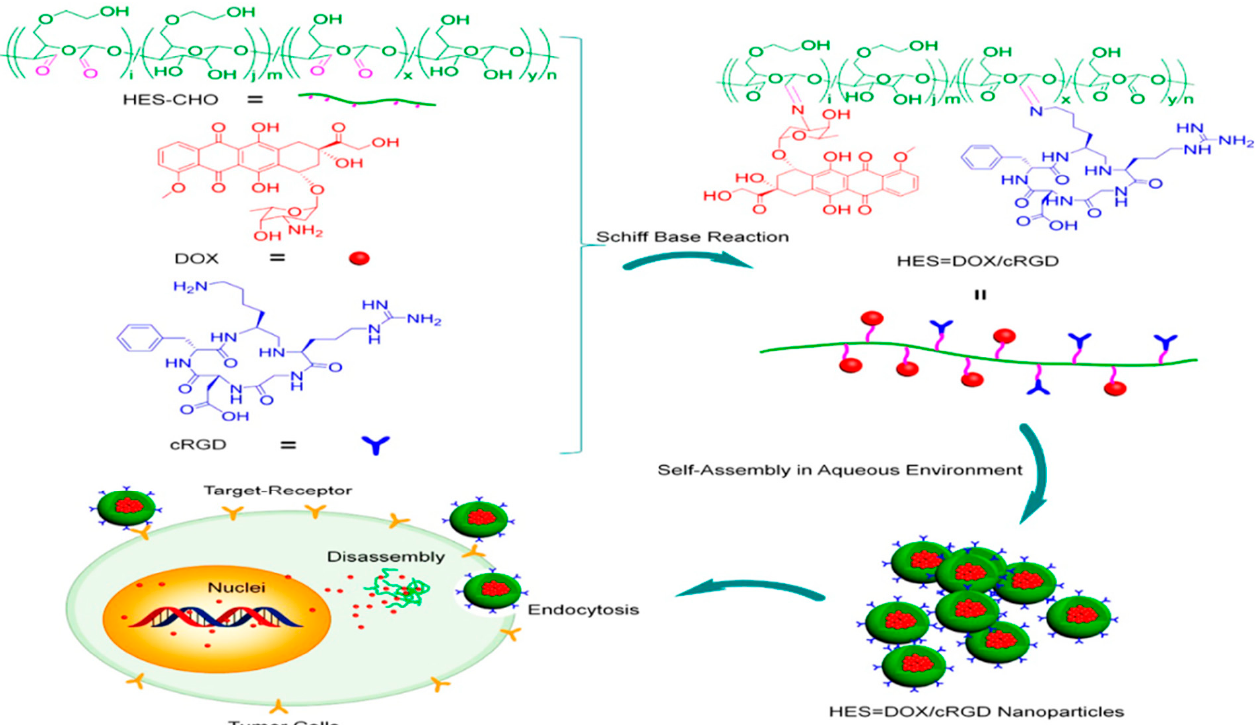
Figure 7. Schematic representation for coupling of dialdehyde hydroxyethyl starch with cyclo(Arg- Gly-Asp-d-Phe-Lys) and Dox via Schiff base reaction for selective localization and pH-dependent release of Dox.